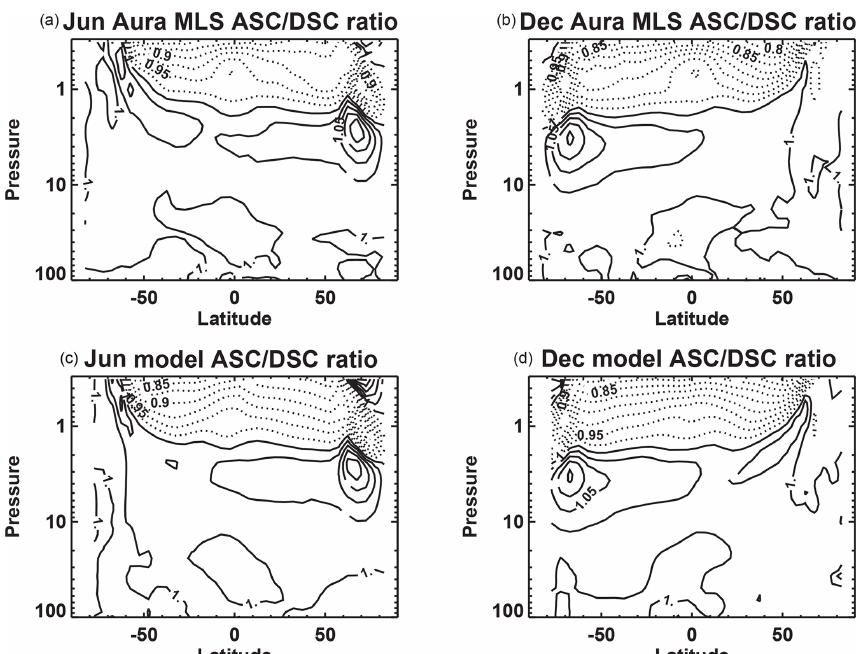
Figure 5. Aura MLS (a, b) and GDOC (c, d) average ratio of ascending (day at most latitudes) to descending (night at most latitudes) average ozone in June (a, c) and December (b, d) as a function of latitude and pressure from 100 to 0.3hPa. The contour interval is 0.025 (2.5%). GDOC is sampled at Aura MLS measurement